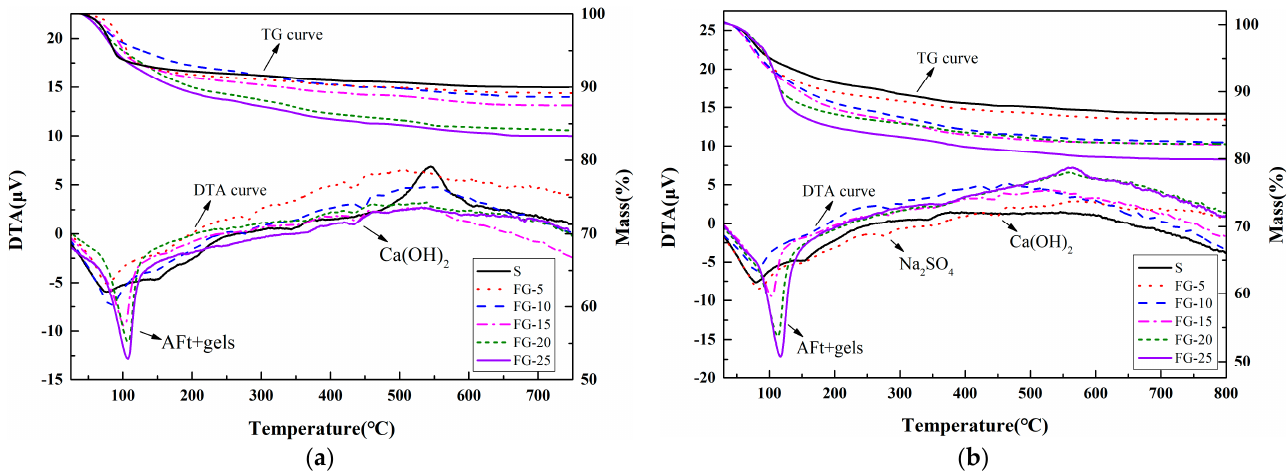
Figure 10. TG-DTA results of cement paste with different FG content: ( a ) 3 days; ( b ) 28 days.